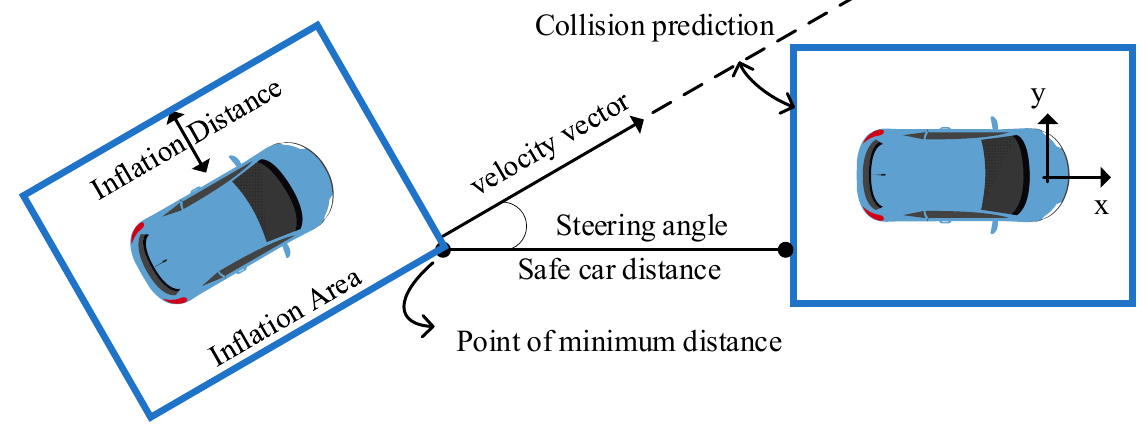
Figure 6. Distance and steering model.